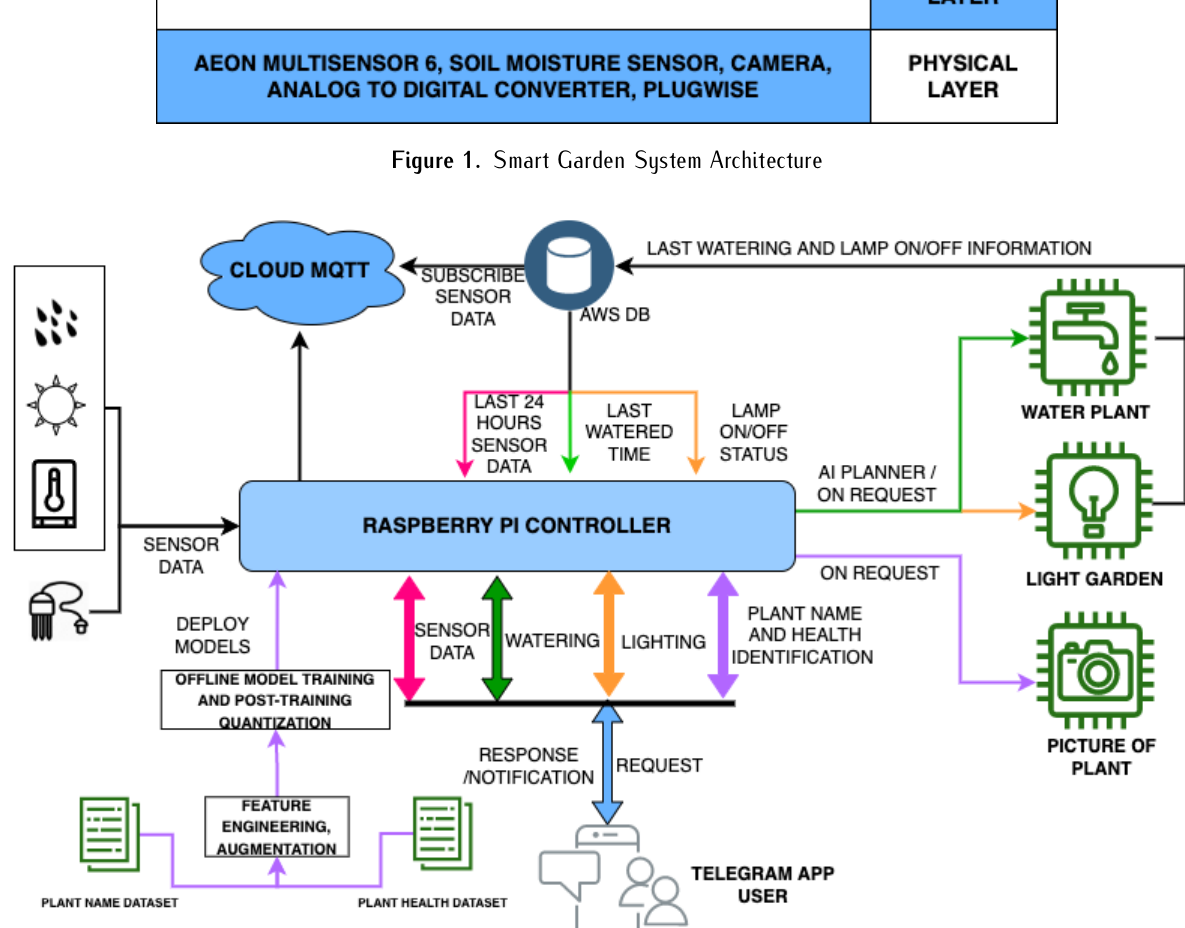
Figure 2. Implementation